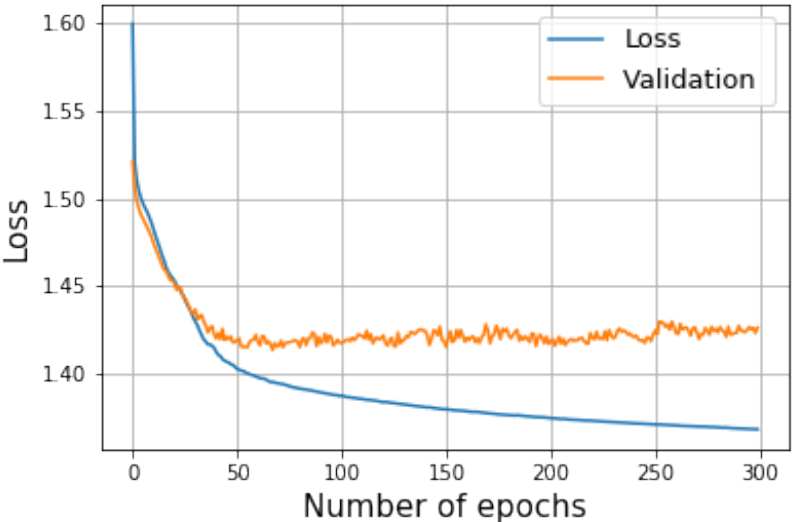
Figure 23. The blue line represents the loss of the training mode and the orange line indicates the loss of the validation mode.